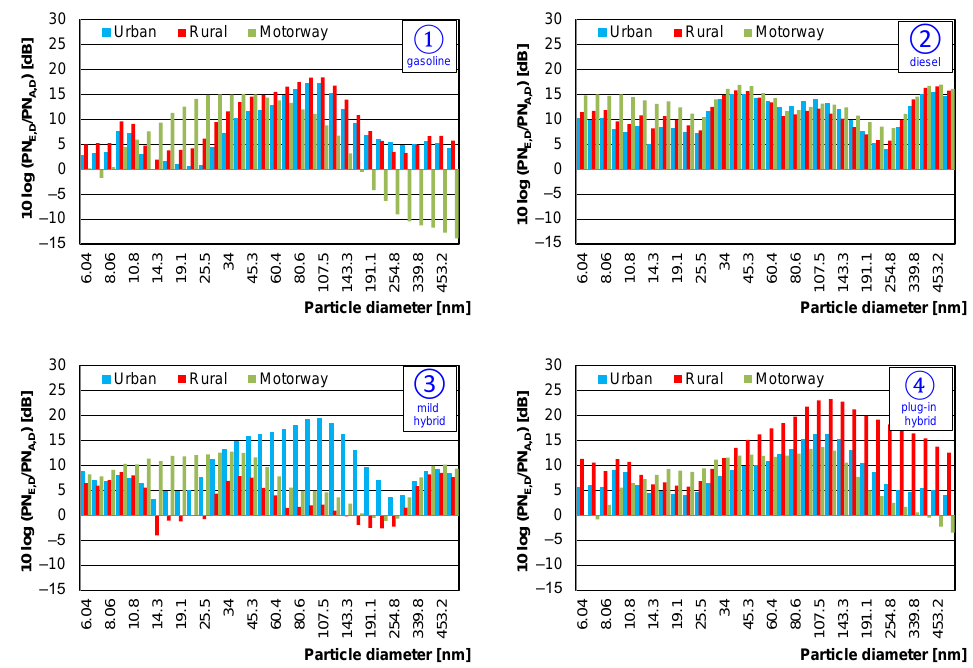
Figure 12. Particle number increase rate for vehicles 1 – 4 in each part of the RDE test (urban, rural, motorway); 1 — gasoline, 2 — diesel, 3 — mild hybrid, 4 — plug-in hybrid.